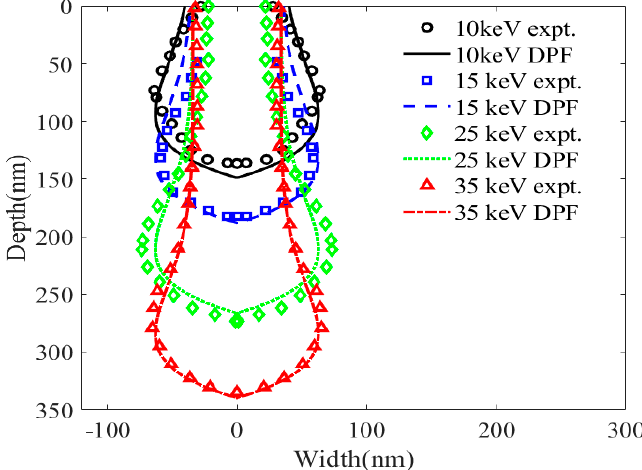
Figure 13. Experiments and DPF calculations of the amorphous damage profile of silicon substrates treated with He-FIB with an ion dose of 0.03 nC/ μ m at beam energies of 10, 15, 25 and 35 keV.